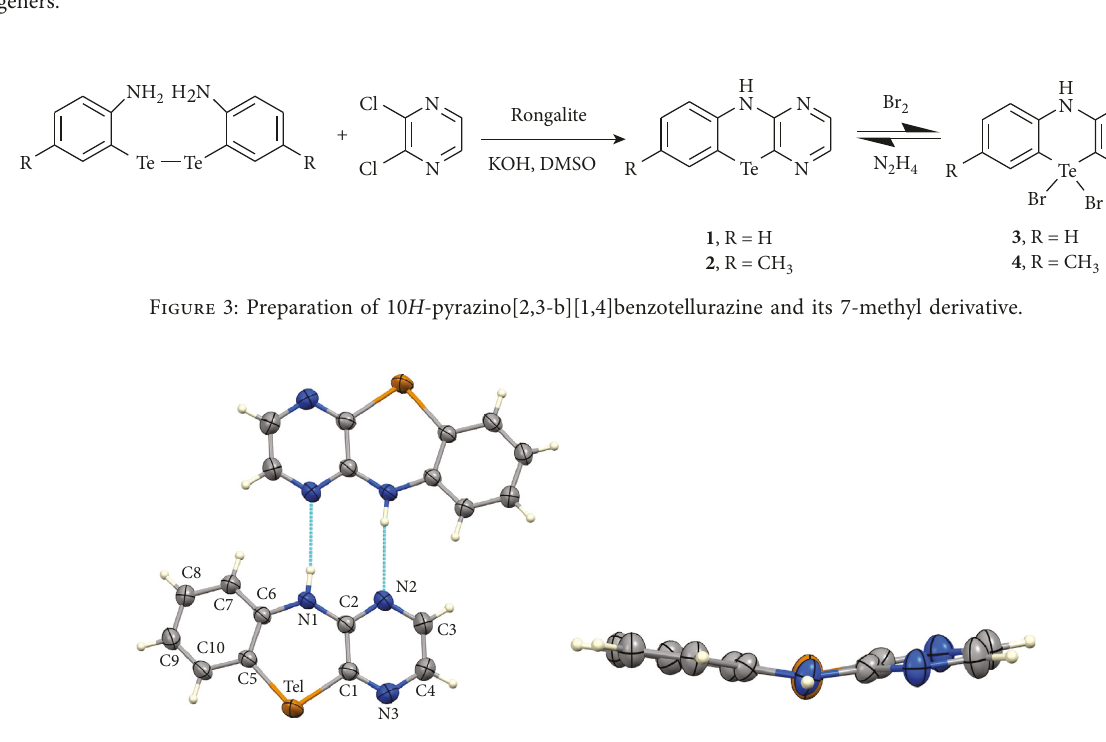
Figure 4: ORTEP plot of the hydrogen-bonded dimer of 10 H -pyrazino [2,3-b][1,4]benzotellurazine and side view showing its